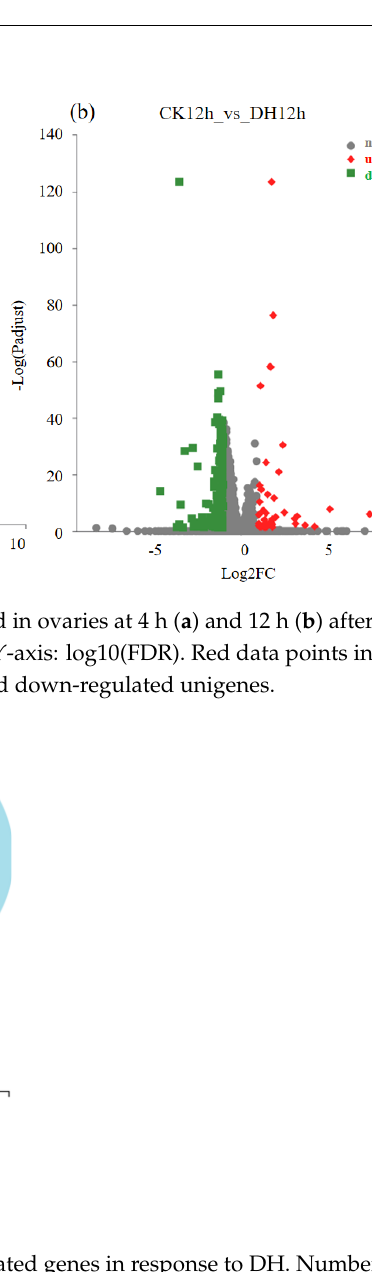
Figure 3. Number of differentially regulated genes in response to DH. Numbers of DEGs (|FC| > 2 and p -adjust < 0.05) between control and DH-treated for 4 h and 12 h. The circles of different colors represent the genes in a gene set, where the value represents the number of genes shared or unique between CK4h_vs._DH4h and